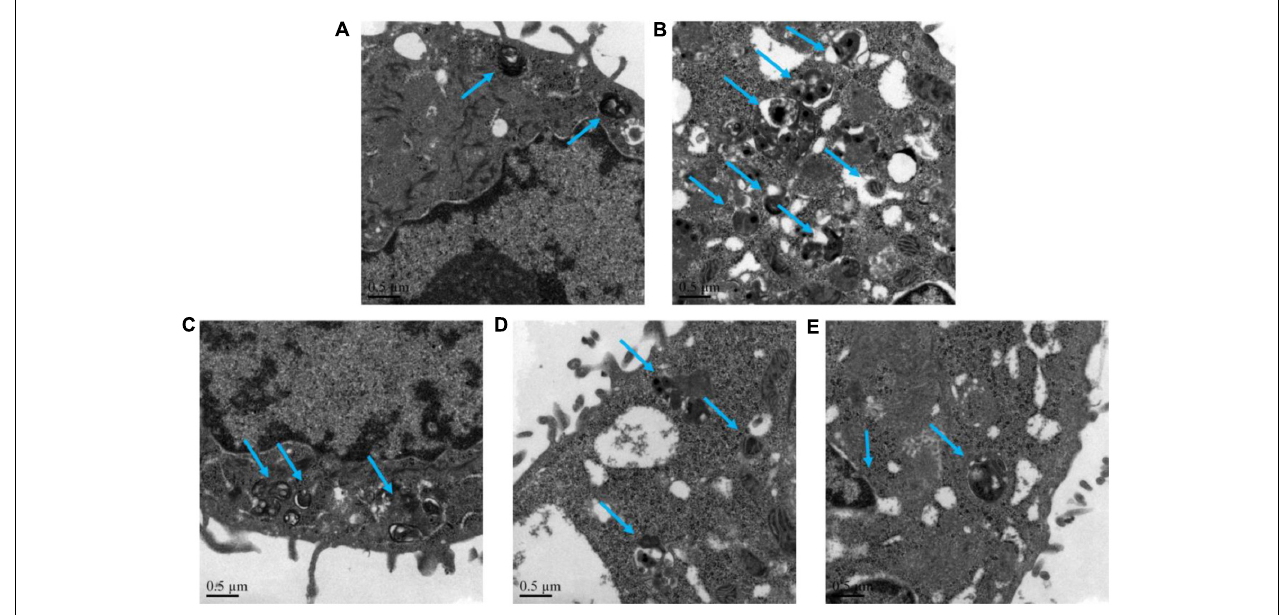
FIGURE 5 | Effects of CCE on autophagy flux of NHBE cells. Transmission electron microscopy was performed to observe the typical autolysosom and representative autophagosome (blue arrows). Autophagy inhibitor chloroquine (CQ) was used to inhibit the excessive autophagy. (A) Blank control; (B) 10%